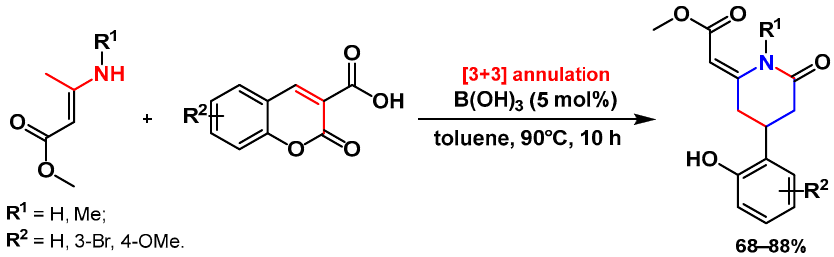
Scheme 52. Piperidine synthesis through palladium(II)-catalyzed ( A ) and organocatalytic ( B ) [4+2]